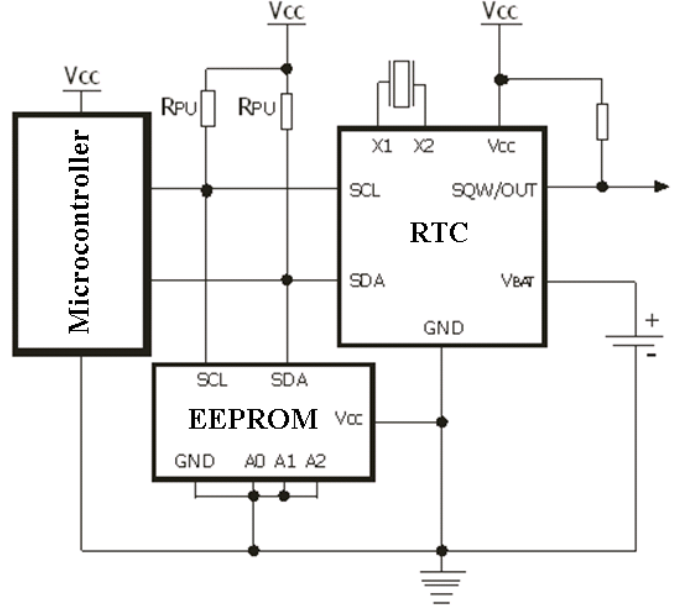
Figure 3. Connection scheme between devices using the I 2 C